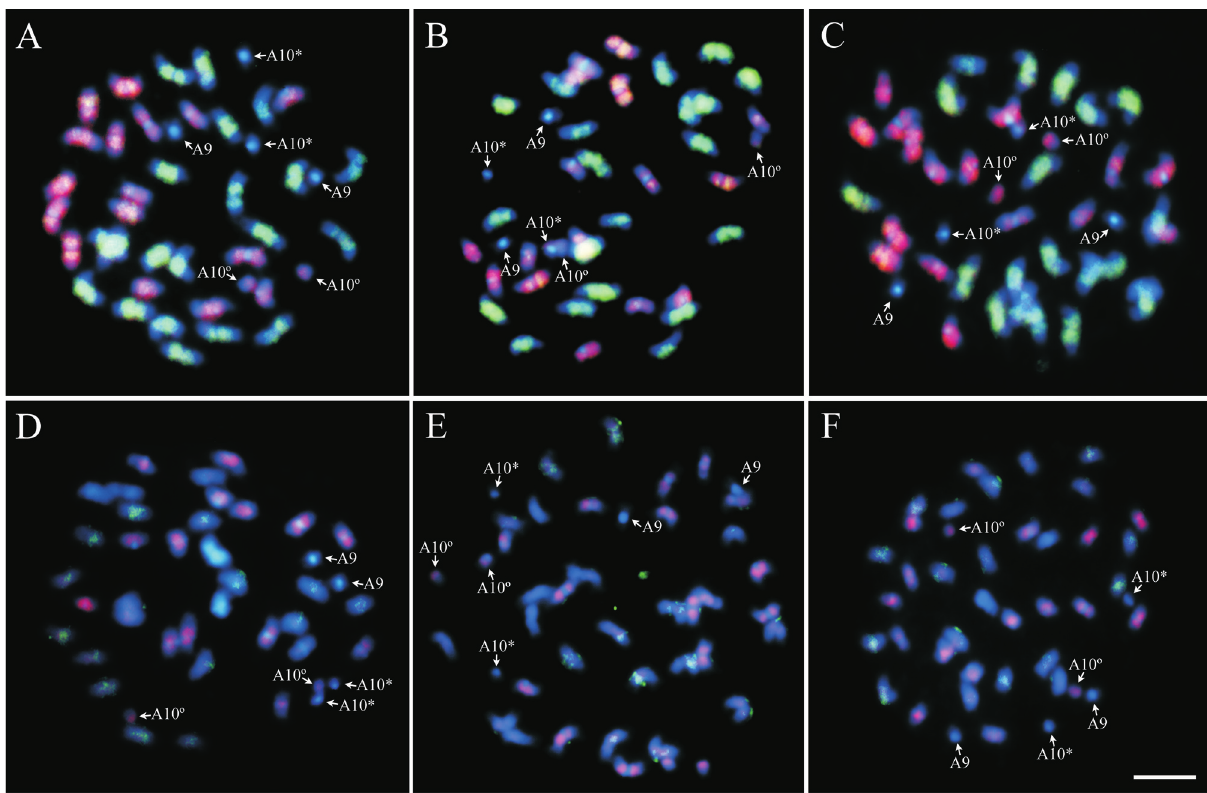
Figure4 -GISHusingsimultaneouslythegenomicprobesfromdifferentdiploidspeciesinXinguaccessions. A,D) Xingu/NambikwaraOf115; B,E) Of 120 and C, F) Xingu type Of 126. Hybridization with A. duranensis (red) and A. ipaënsis (green) probes (A, B, C), followed by DAPI counterstaining (blue), including the overlap of signals (greenish) of both probes. More discrete signals after hybridization with the probes from A. stenosperma (red) and signalsalmostabsentin A.magna (green)(D,E,F).A10withsecondaryconstriction,shortarmandproximalsegmentofthelongarm(*)andsatellite(°). Bar: 5 (cid:2)